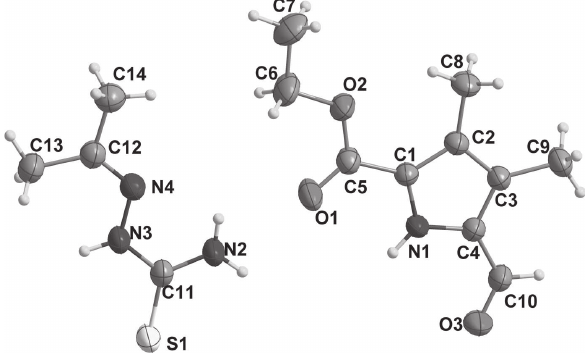
Table 2: Fractional atomic coordinates and isotropic or